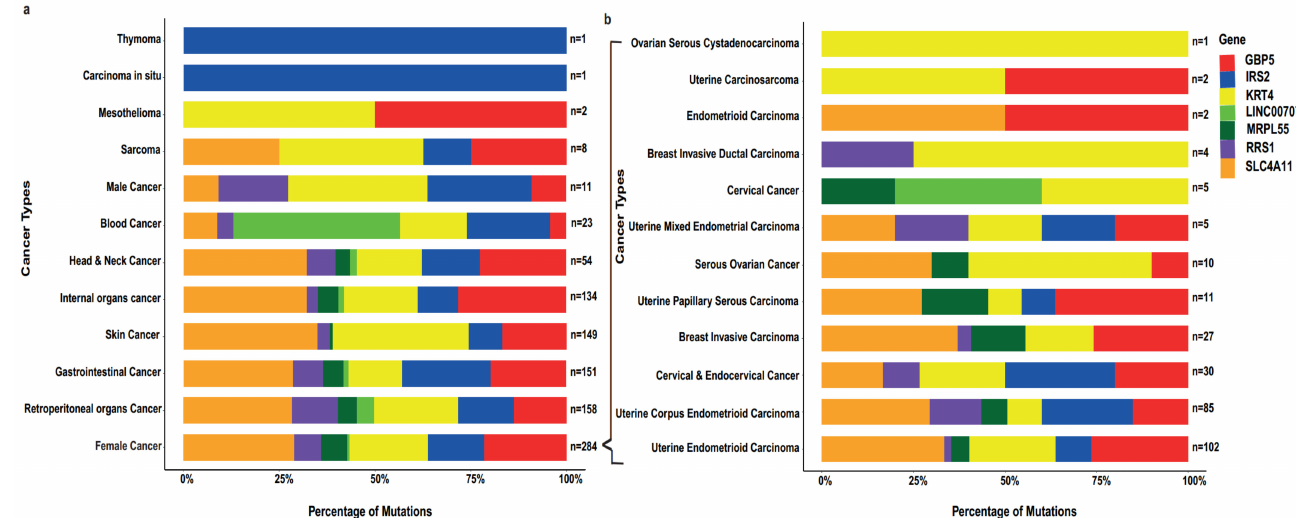
Figure 4. ( a ) Bar plot showing the sample size and percentage of mutation in seven biomarkers in each human cancer type, ( b ) with emphasis on female